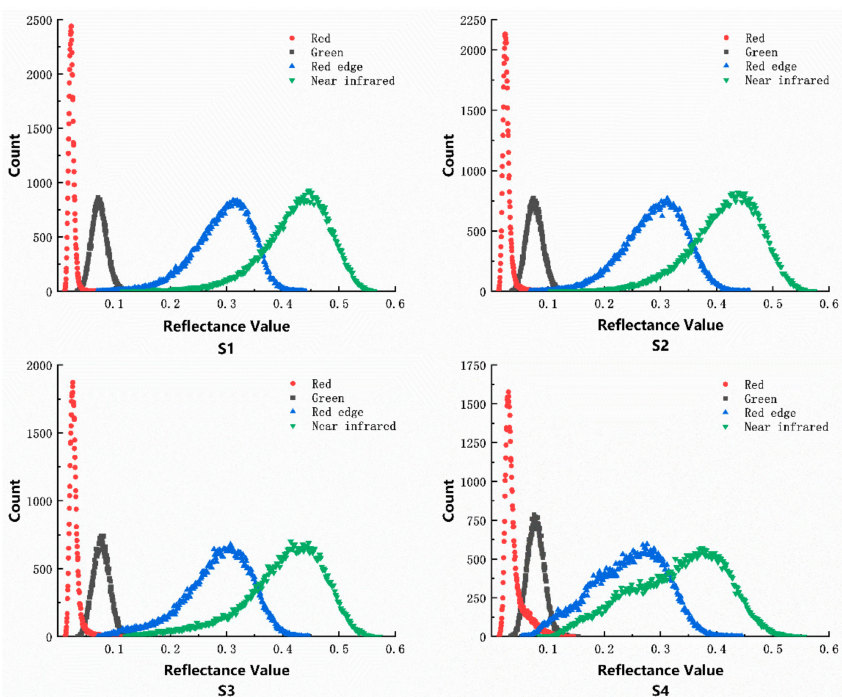
Figure 2. Histogram of the reflectance at di ff erent wavelengths for the peanut plants grown at di ff erent densities (S1, S2, S3, S4). p = 0.01, the correlation is significant.